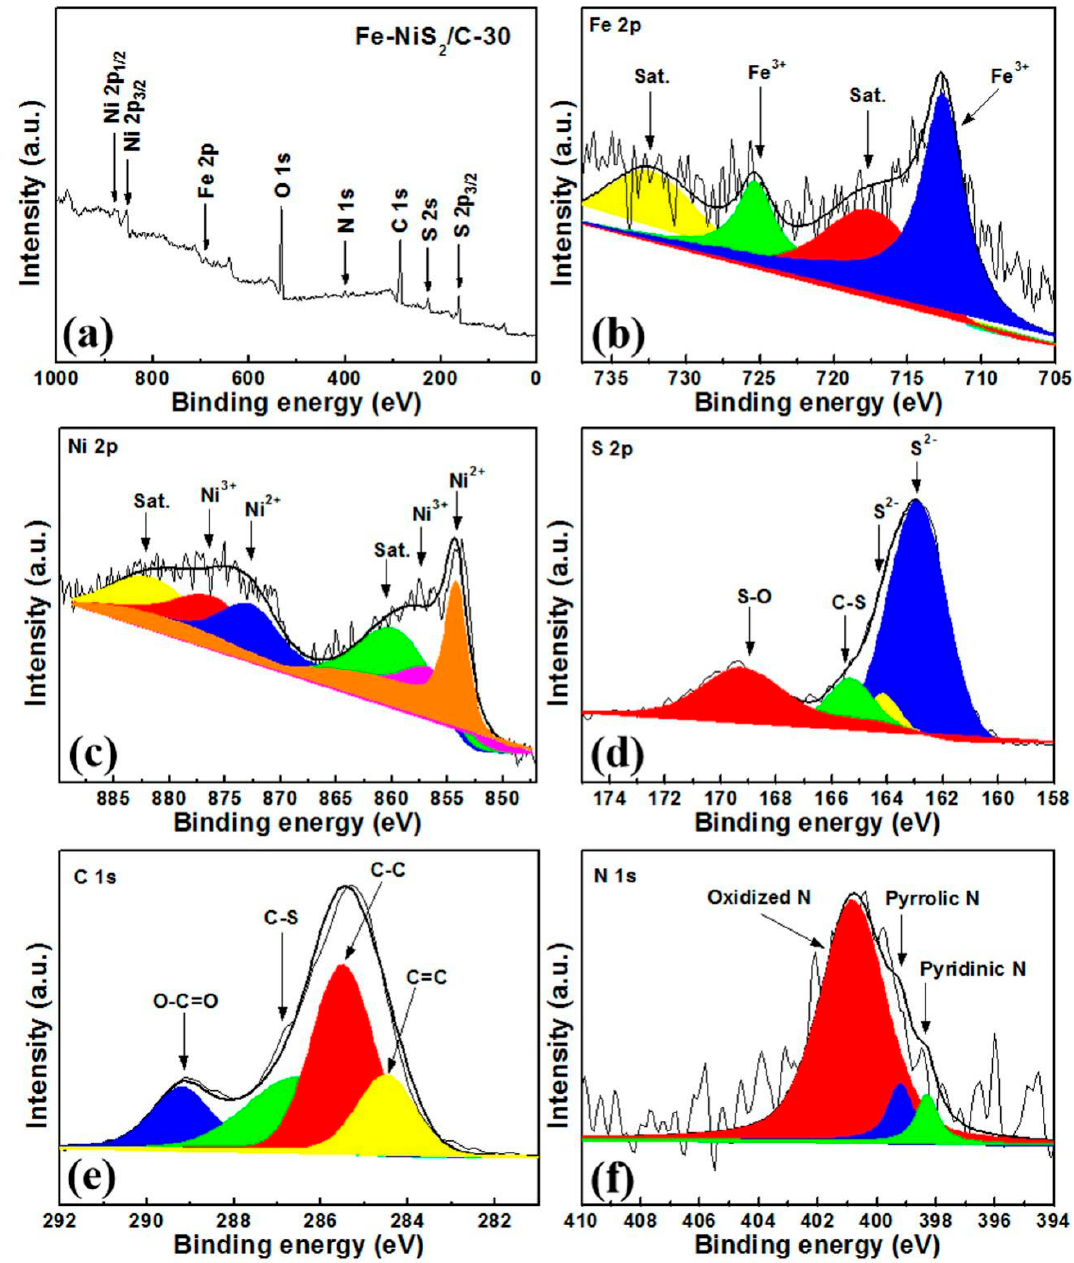
Figure 5. XPS ( a ) survey spectra and high-resolution spectra of ( b ) Fe 2p, ( c ) Ni 2p, ( d ) S 2p, ( e ) C 1s, and ( f ) N 1s for the Fe-NiS 2 /C-30 sample.